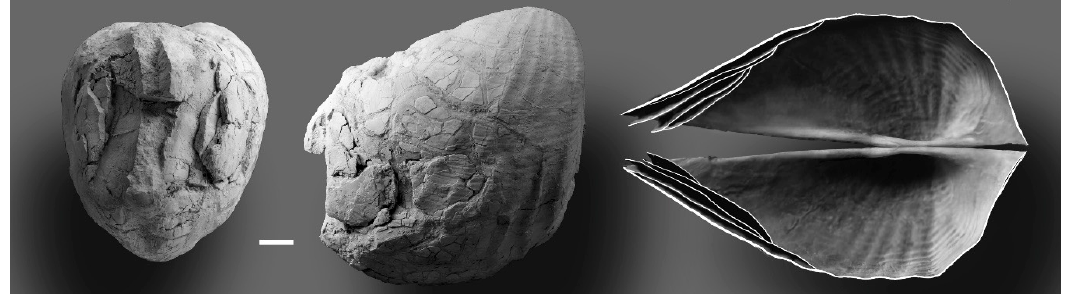
Figure 14. Specimen extremely affected by pathology in form of mud blisters (or pockets) (described in detail in [39]). The restriction of the posterior part of the shell interior must have impaired the functioning of the siphon; Ph. lirata (Lower Bathonian, Cz ę stochowa, Polish Jura, MGUS.Sz.3888), posterior and right view, and approximate scheme of the longitudinal section of the specimen.